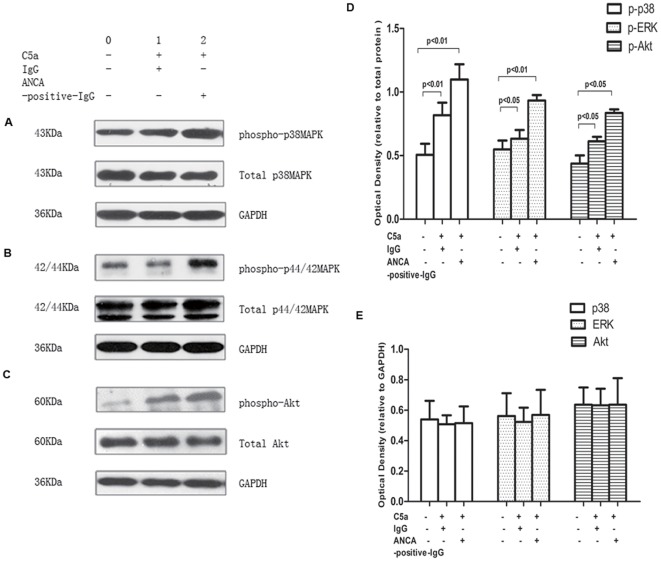
Western blot analysis for phospho-p38MAPK, phospho-ERK and phospho-Akt.Neutrophils were stimulated with C5a 100 ng/ml or buffer for 15 min followed by stimulation with normal IgG, MPO-ANCA-positive IgG or PR3-ANCA-positive IgG, and buffer control, respectively. Samples were harvested and phospho-p38MAPK (pp38, A), phospho-ERK (pERK, B) and phospho-Akt (pAkt, C), were determined by immunoblotting. A representative example of 4 independent experiments is shown. GAPDH is shown as loading control. 0: blank, 1: C5a+isotype control; 2: C5a+ANCA-positive IgG. The corresponding densitometric analysis was shown in D for phosphorylated protein relative to total protein and E for total protein relative to GAPDH (n = 4). Differences of optical density between groups were assessed using the t test.